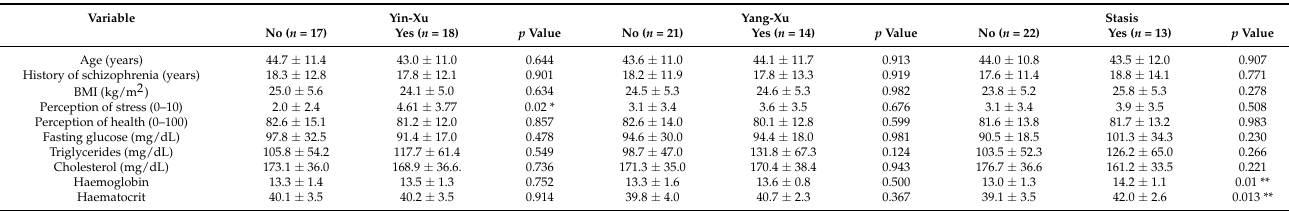
Table 1. Comparisons of participants’ characteristics and biomarkers between constitutions of Yin-Xu, Yang-Xu, and Stasis (treated with risperidone, n = 35).